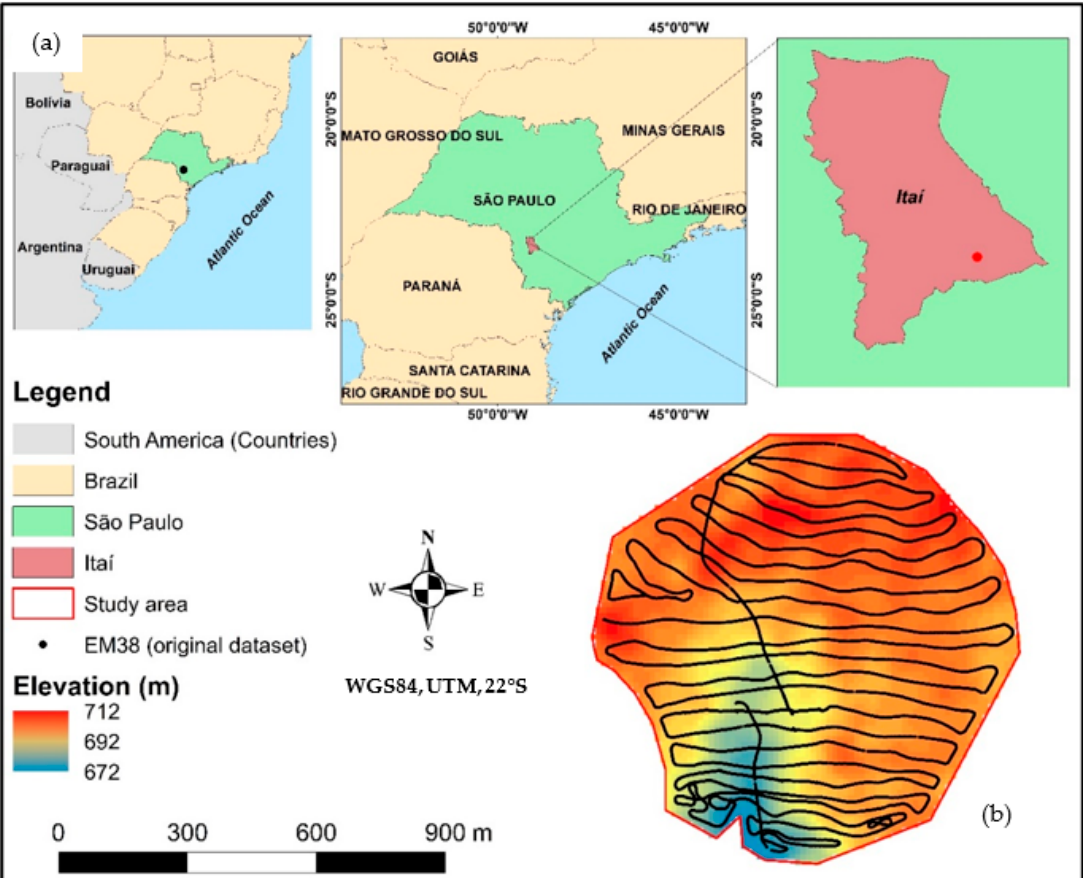
Figure 1. Maps showing ( a ) study area location and ( b ) navigation path over elevation.